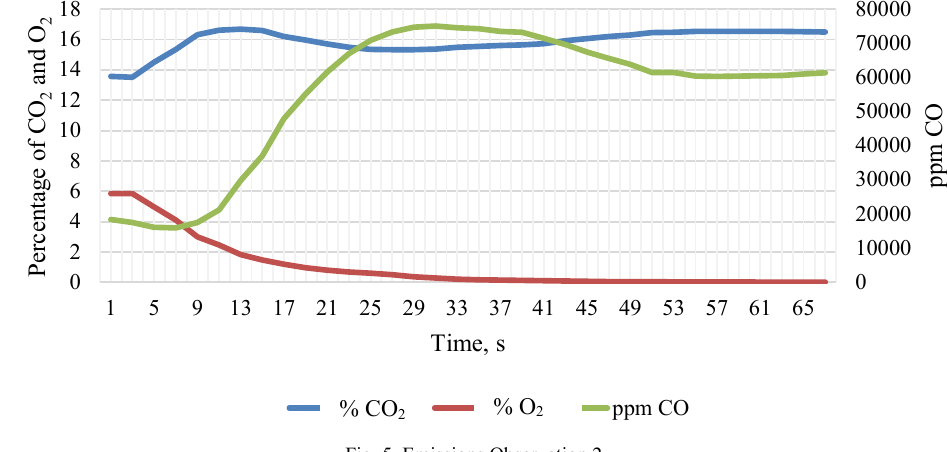
Fig. 5. Emissions Observation